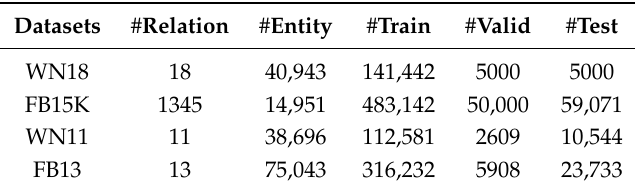
Table 5. The statistics of